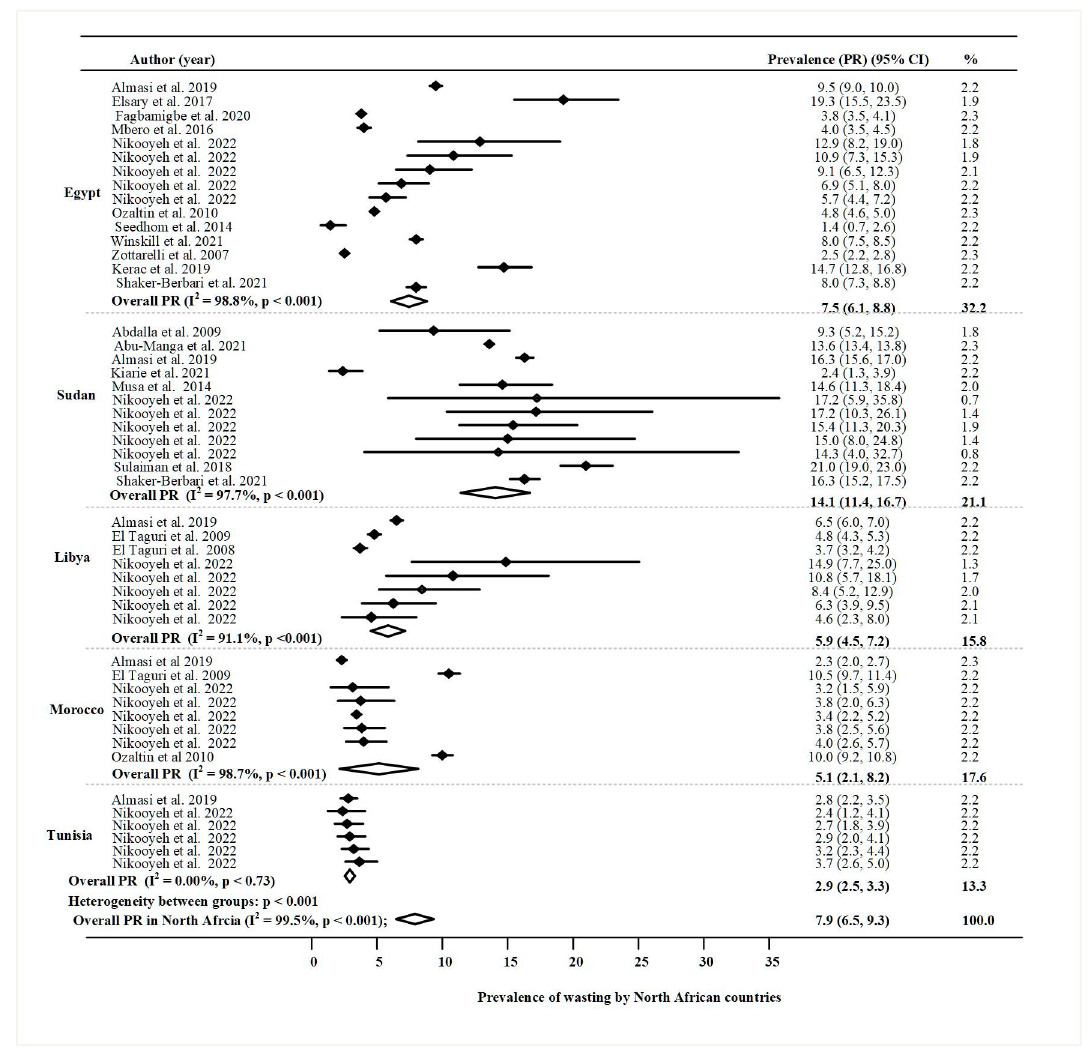
Fig 3. Prevalence of wasting in North Africa by